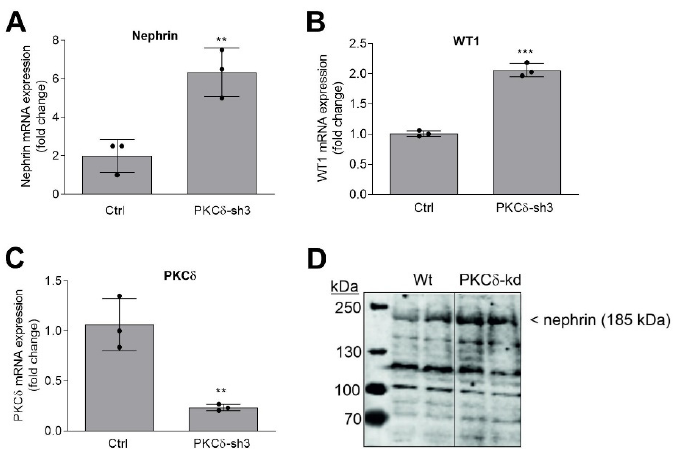
Figure 4. The effect of the stable knockdown of PKC δ on nephrin and WT1 mRNA and protein expression in podocytes. ( A ) Podocytes that were stably downregulated for PKC δ (PKC δ -sh3; PKC δ -kd) were taken for either RNA ( A – C ) or protein ( D ) extraction. RNA was used for the quantitative PCR analysis of nephrin ( A ), WT1 ( B ), and PKC δ ( C ) mRNA expression. 18S RNA